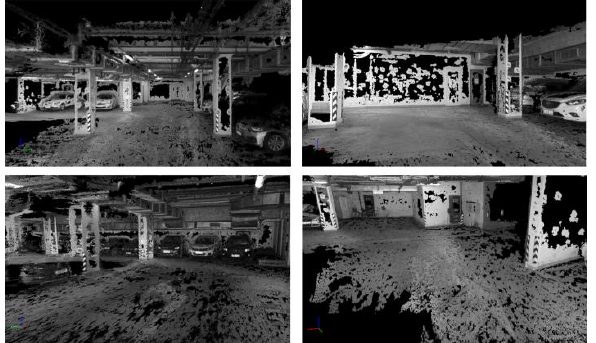
Figure 5. Detail 3D map of different